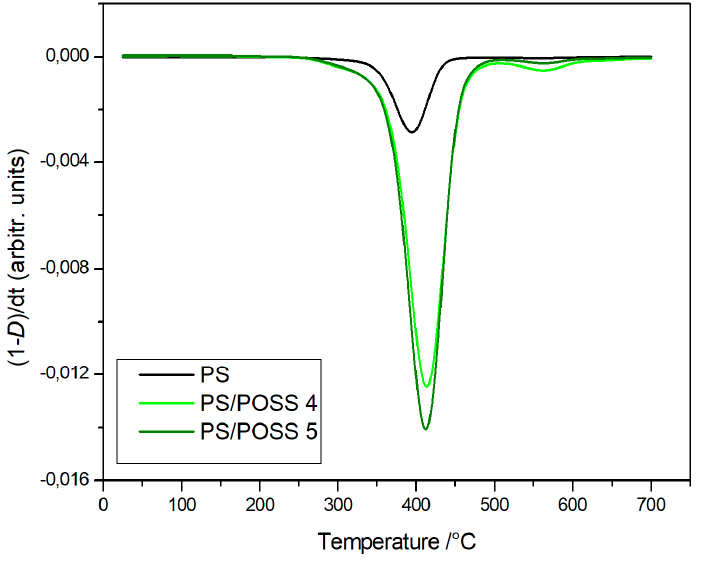
Figure 11. Differential thermogravimetric curves, in an inert atmosphere, for PS and samples 4 and 5 .